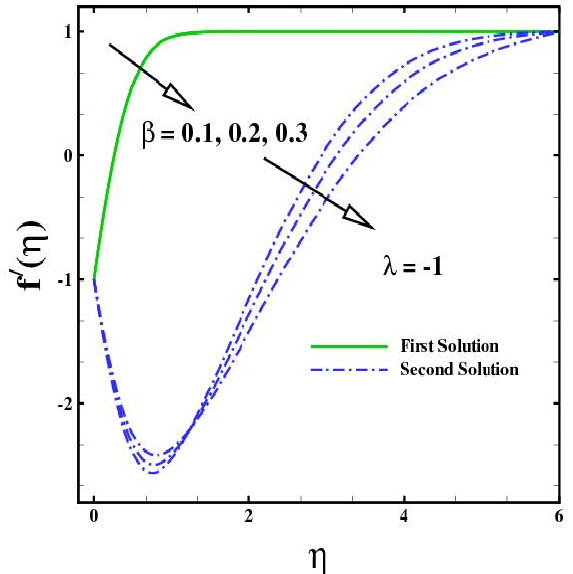
Figure 7. Impact of f ʹ ( η ) with several values of β and We = 0.3, n = 2, M = Ec = 0.5, Pr = 3, S = 4, and A = B = 0.1.